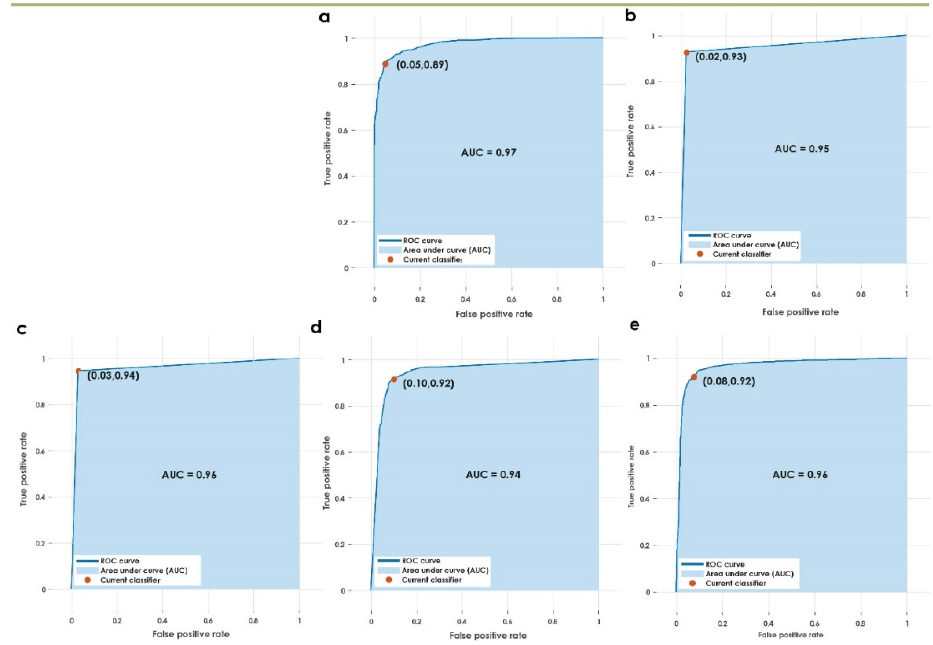
Figure 5. AUC for the various classifiers used in the proposed approach. ( a ) Weighted KNN, ( b ) fine KNN, ( c ) optimizable KNN, ( d ) wide NN, ( e ) cubic SVM.